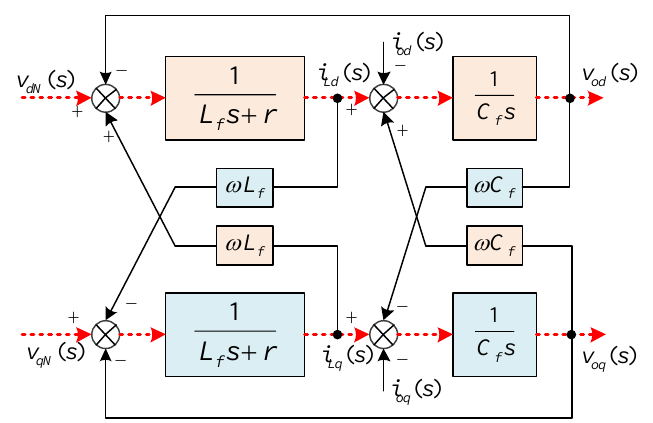
Figure 3. The shortest path of LC inverter model in s